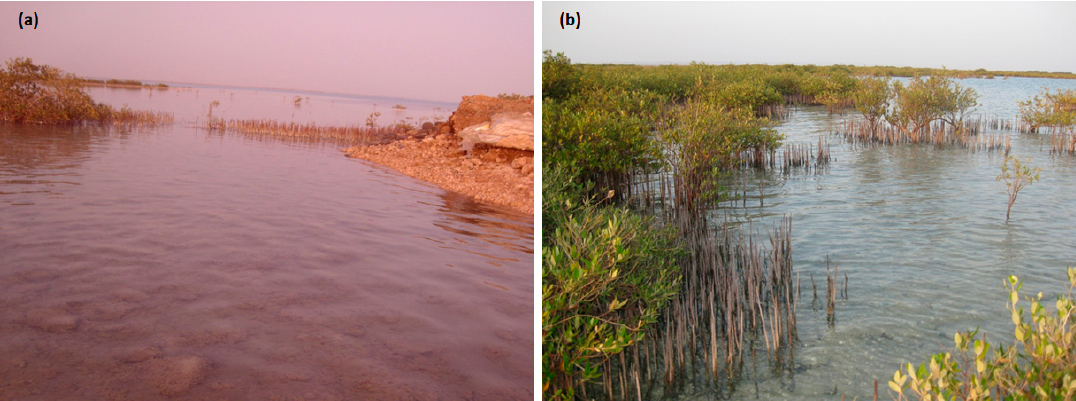
Figure 16. Photos from field visits: ( a ) 1993 showing disturbed mangroves and ( b ) 2019 showing recovering mangroves at site in extreme northwest.